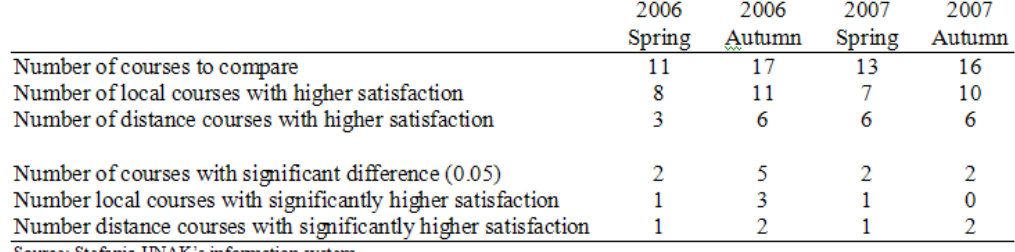
Table 7. Comparison of local and distance students’ attitudes towards